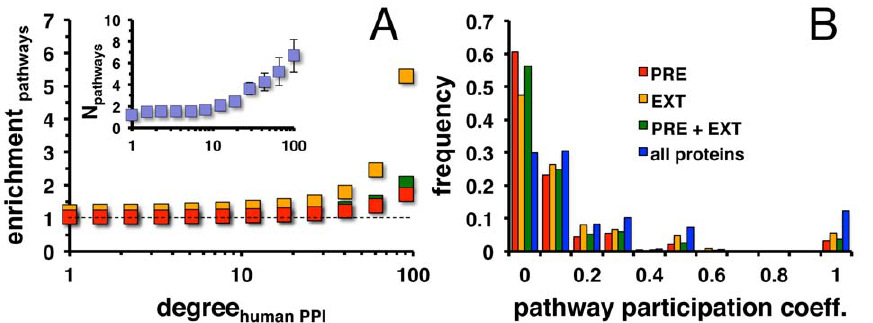
Figure 4. Pathway specific characteristics of predicted and external interactions. ( A ) In a network of human protein interactions the mean number of pathways a given human protein is involved in increased with the number of interaction partners (inset). The enrichment of such targeted pathways was determined as a function of their number of interaction partners. Utilizing predicted (PRE), external (EXT) and both sets (PRE + EXT) of host-parasite interactions, highly connected, targeted proteins appeared to be increasingly involved in such pathways. ( B ) A low value of the pathway participation coefficient indicated that the interaction partners of a protein in a human protein interaction network reached many different pathways and vice versa. Considering all human proteins that were involved in pathways, the majority of proteins have low pathway participation coefficients. Considering targeted proteins in all sets of host-parasite interactions the initially observed trend was significantly reinforced in all cases (Wilcoxon rank-sum test, P , 10 2 10